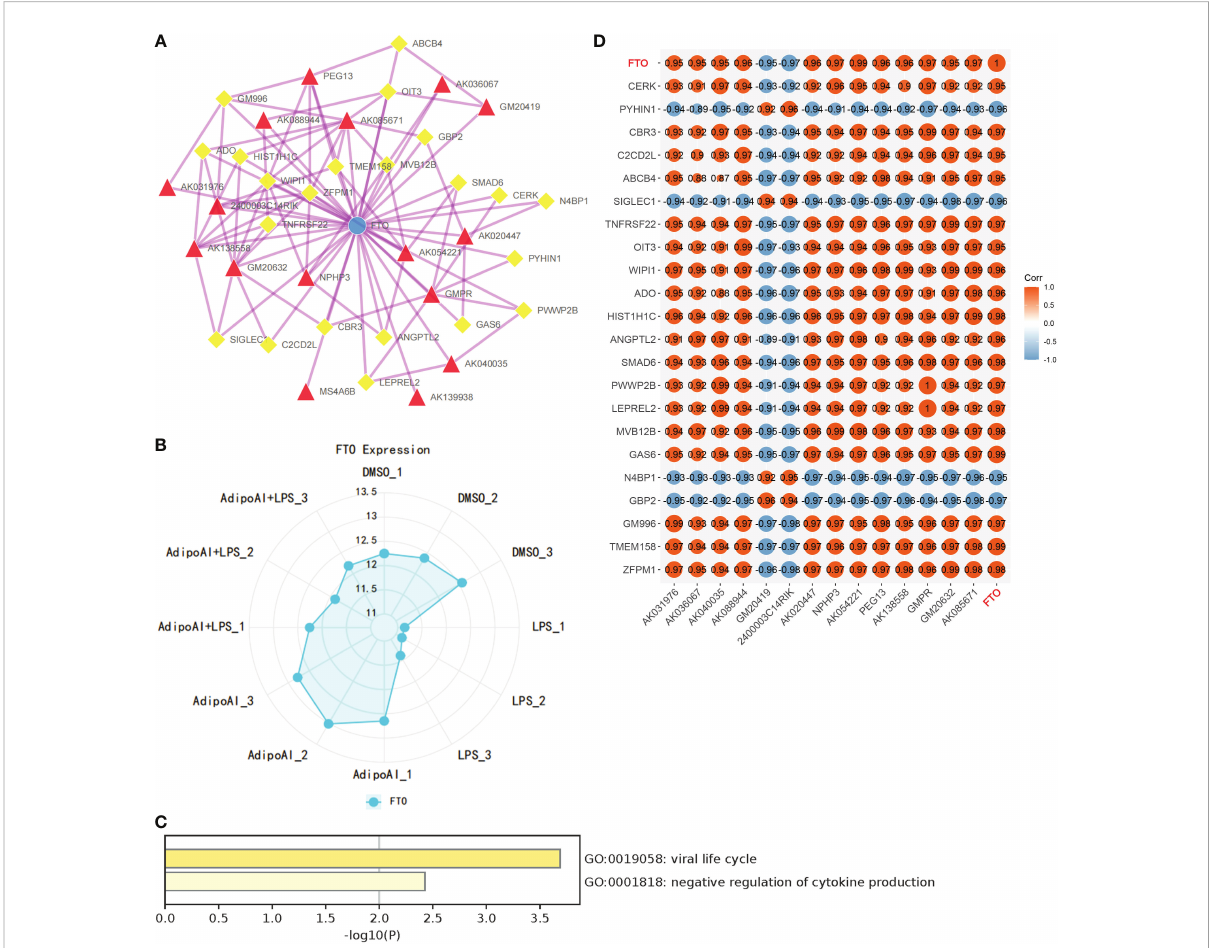
FIGURE 7 Construction of m6A regulator lncRNA ‒ mRNA networks. (A) FTO (M6A regulator)-lncRNA ‒ mRNA network. (Blue Ball: m6A regulator; Red Triangle: lncRNA; Yellow Square: mRNA). (B) FTO expression levels in 12 samples. (C) GO analysis for mRNAs in the network. (D) Coexpression validation for FTO, mRNAs and lncRNAs in